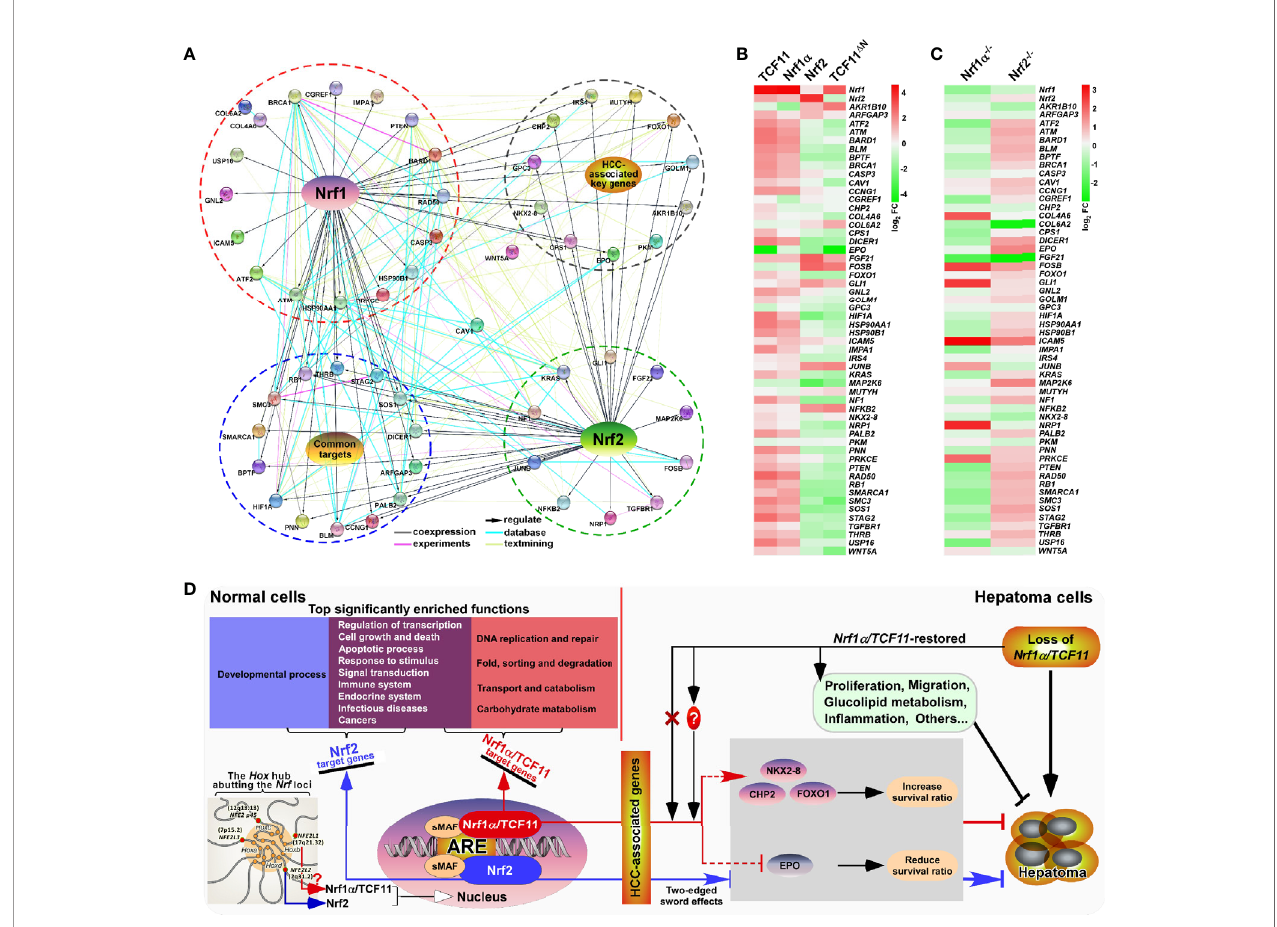
FIGURE 9 | Relationship and difference between the regulation patterns of Nrf1 and Nrf2 on their targets. (A) The functional protein association networks of targets regulated by Nrf1 or Nrf2. Of note, the protein-protein associations are determined by various ways, which are thus represented by different colored edges as indicated. (B) The heatmap of the sequencing expression of genes, which are composed of the network, with distinct expression levels in TCF11 , Nrf1 a , Nrf2 and TCF11 D N cell lines. The color of the nodes in the heatmap represents the value of log 2 (fold change) as shown in the color bars, indicating the gene expression trend as compared with the control group (upregulation or downregulation, were marked in red or green, respectively). (C) The heatmap of the sequencing expression of genes in Nrf1 a − / − and Nrf2 − / − cell lines. The color of the nodes in the heatmap represents the value of log 2 (fold change) as shown in the color bars, indicating the gene expression trend as compared with the wild-type HepG2 cells. (D) A comprehensive regulatory model is proposed to reveal the different effects of Nrf1 and Nrf2 on hepatoma ( right panel ). In addition, the Hox hub abutting the distinct Nrf loci was also indicated ( at the lower left corner